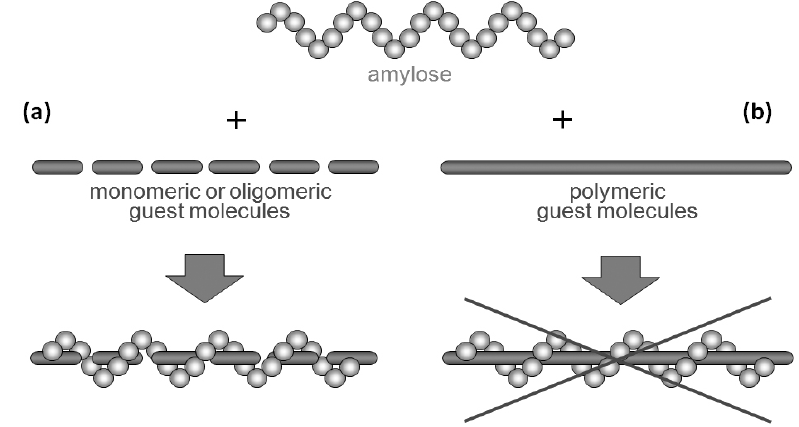
Figure 2. Amylose forms inclusion complex with relatively low molecular weight hydrophobic molecule ( a ); but, mostly, does not form it with polymeric molecule ( b